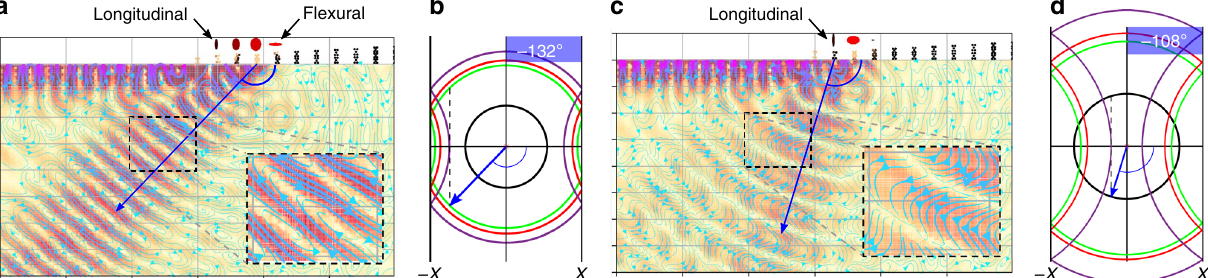
Fig. 3 Simulations of reversed conversion by Umklapp scattering. a S conversion for excitation at f = 1.2 MHz, predicted using isofrequency contours shown in b . c P conversion for excitation at f = 1.45 MHz, predicted using isofrequency contours shown in d . In each case at the position of conversion is determined by the change from longitudinal to fl exural motion of neighbouring rods. The ratio of the relative magnitude of longitudinal to fl exural motion is shown by the ellipses above the rods. The angle of conversion, computed directly from the simulated fi eld transformed in the wavenumber space, matches the predictions from the isofrequency curves of the last rods supporting the longitudinal mode, similarly to Fig. 2c. The difference between the converted wave types (S and P) can be seen clearly from the streamline analysis. Wavenumber analysis on the simulated data also con fi rmed the two different velocities ~3000 m s − 1 for S and 6000 m s − 1 for P. Array parameters are detailed in Supplementary Table